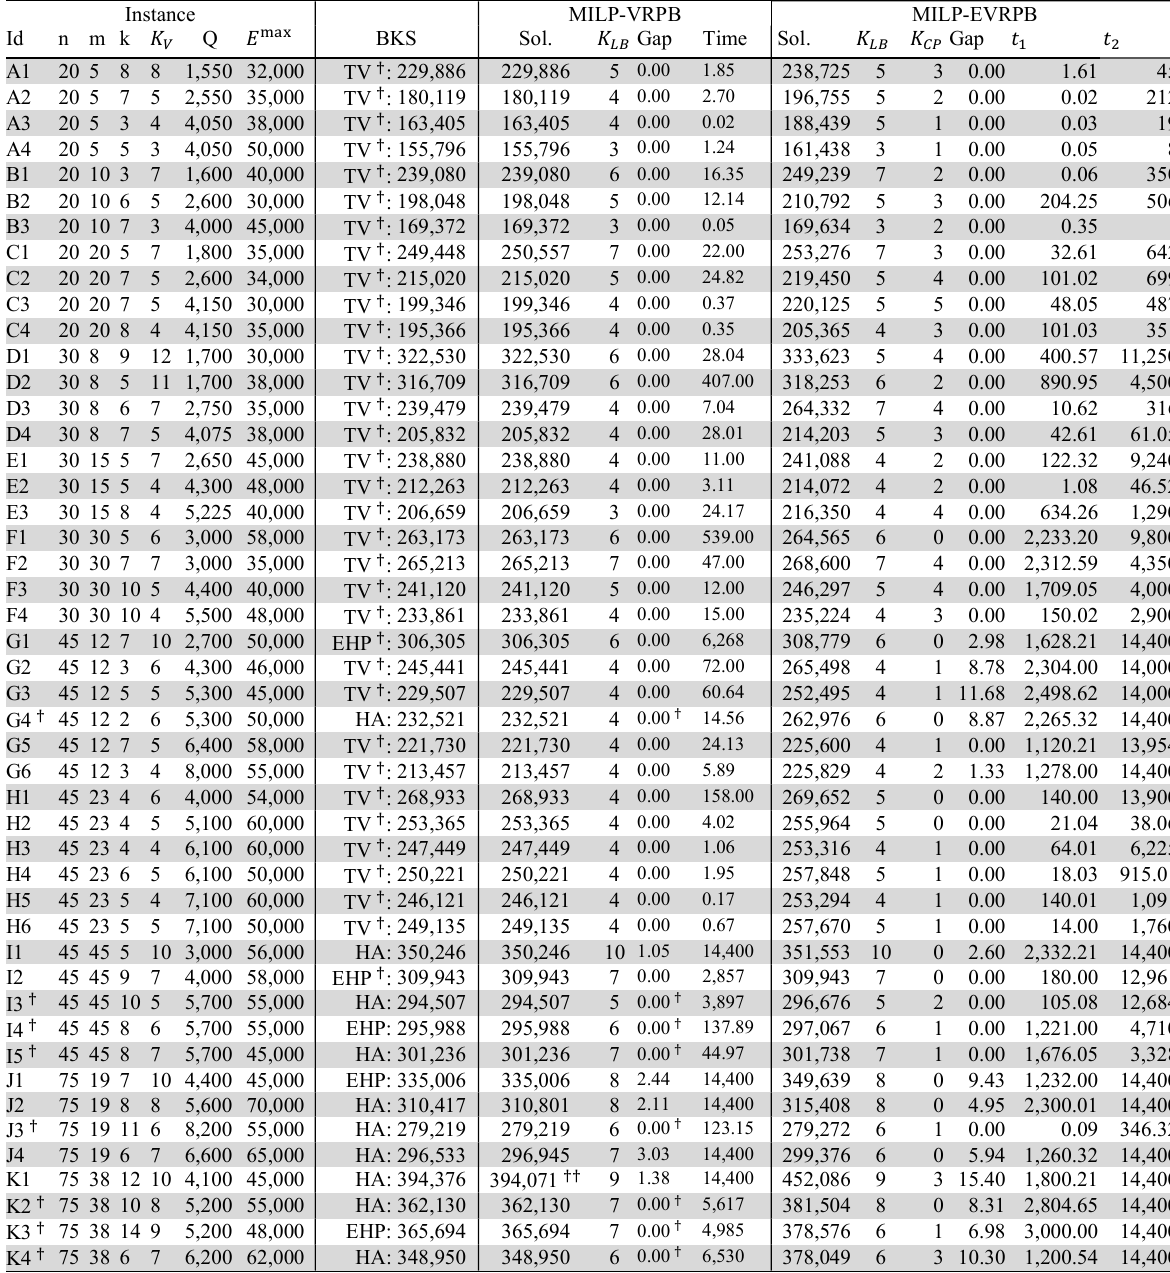
Computational results for the VRPB cases from Goetschalckx and Jacobs-Blecha